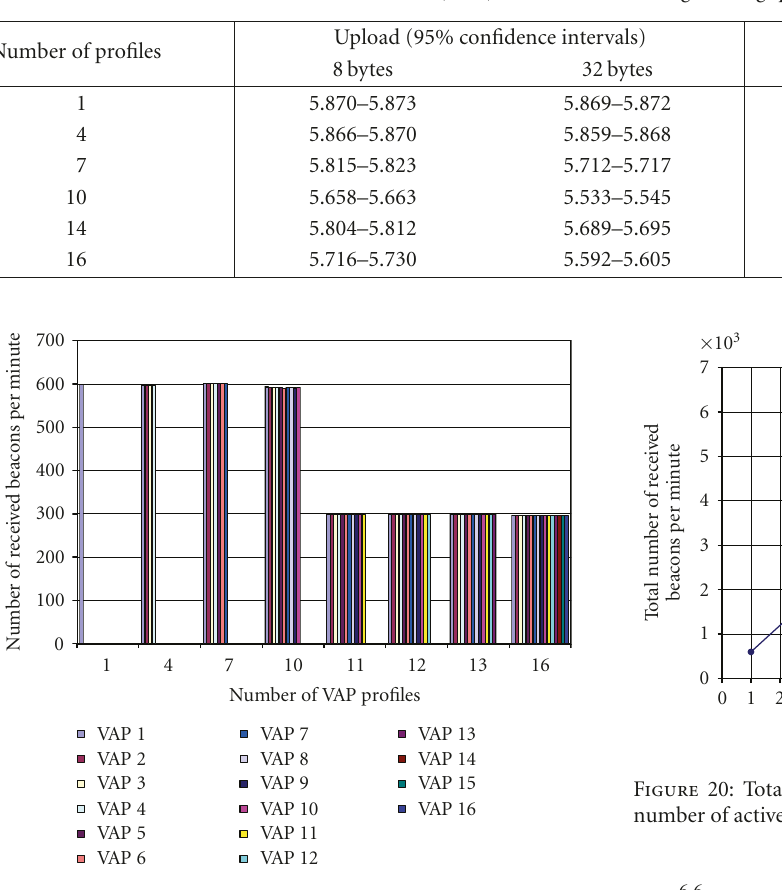
Figure 19: Number of beacons per minute.